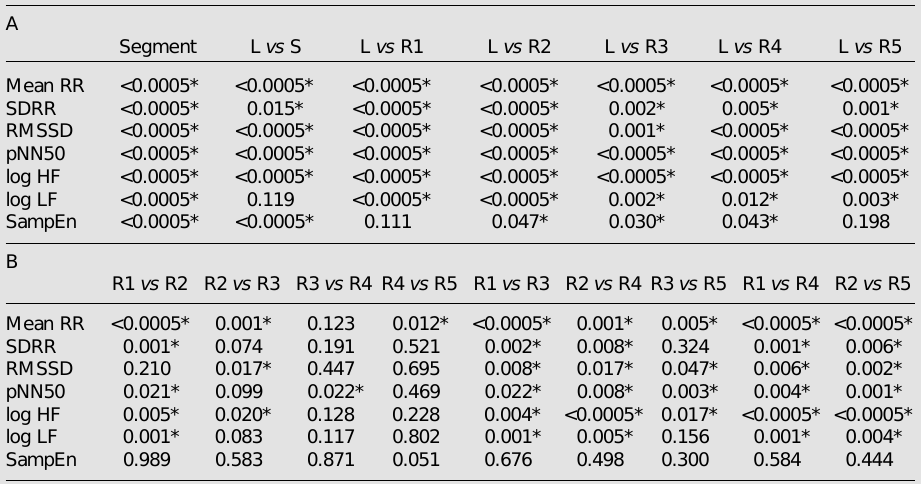
Table 1. Comparisons of heart rate variability and heart rate complexity indices using repeated measures ANOVA with contrasts.